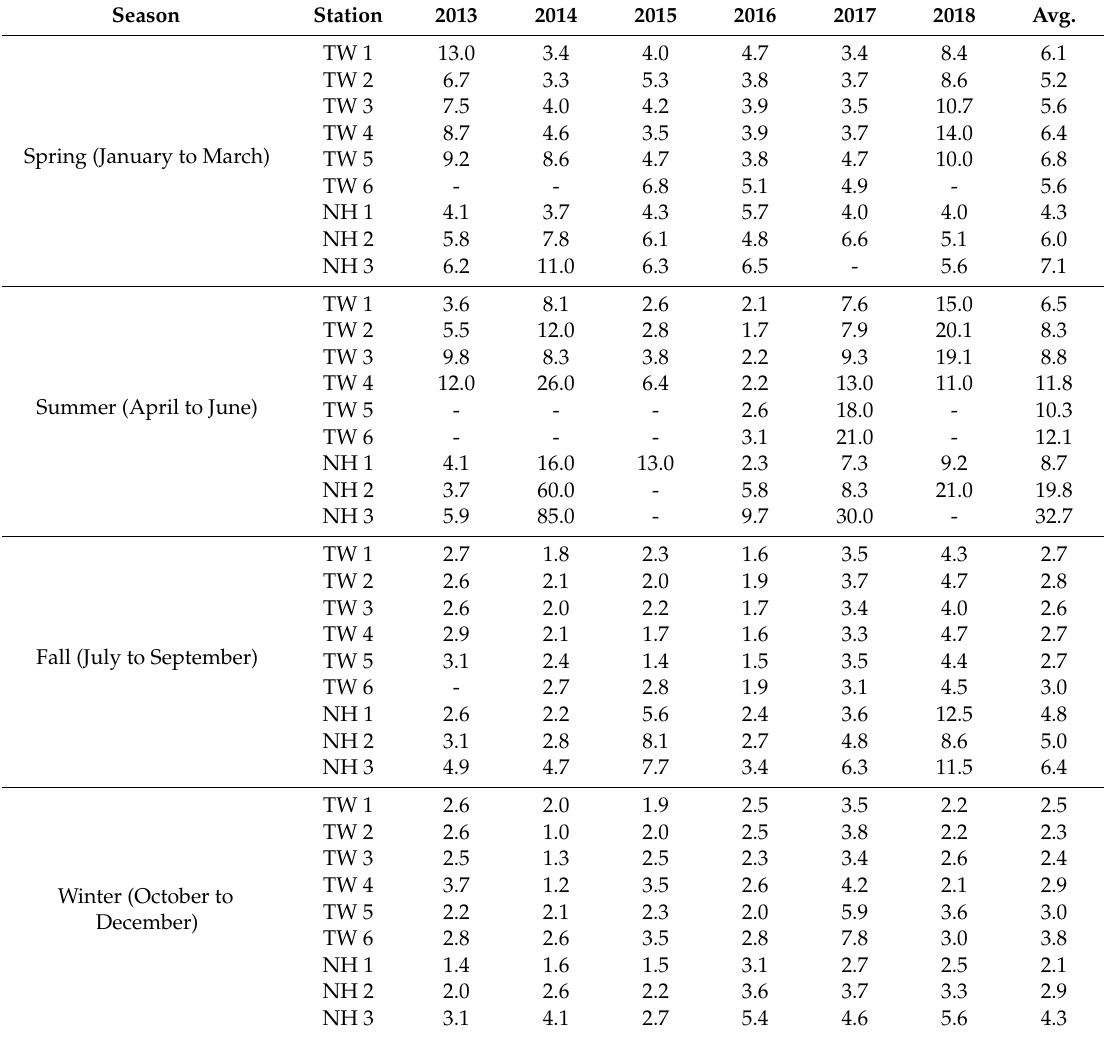
Table 1. Yearly turbidity data of Tseng-Wen and Nan-Hwa